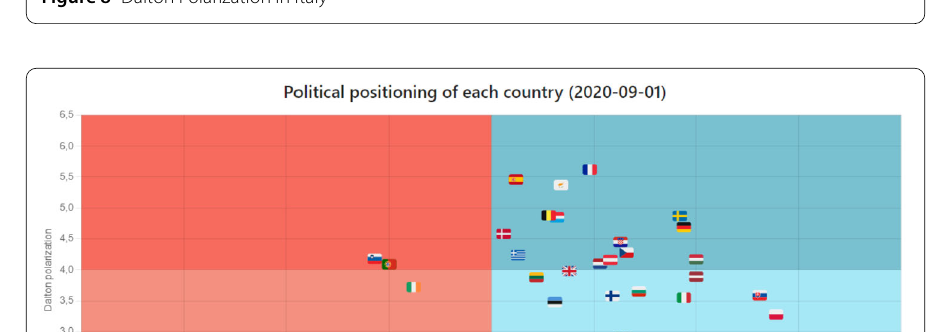
Figure 8 Dalton Polarization in Italy